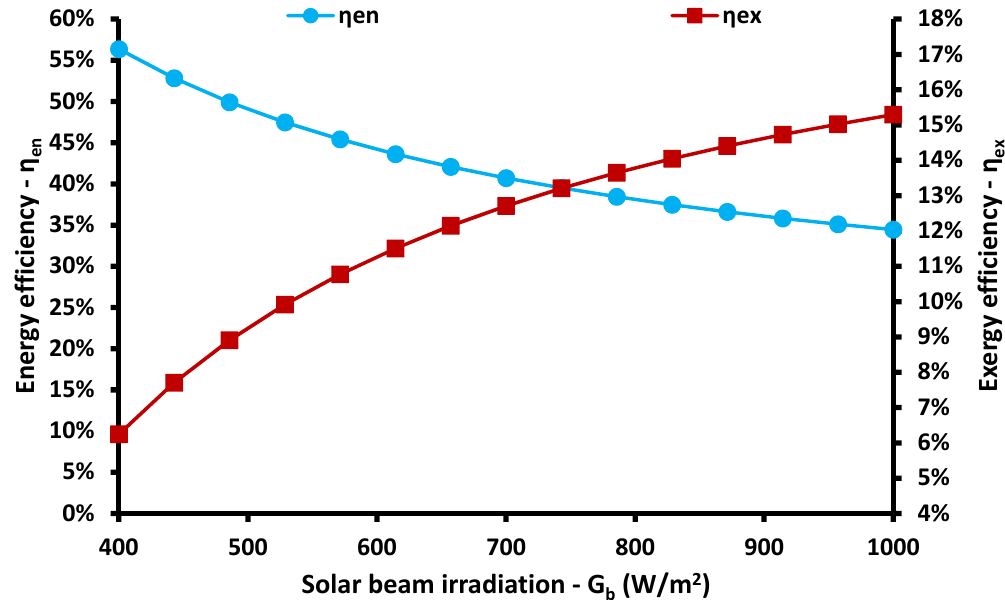
Figure 18. Energy and exergy e ffi ciency for di ff erent solar irradiation levels.